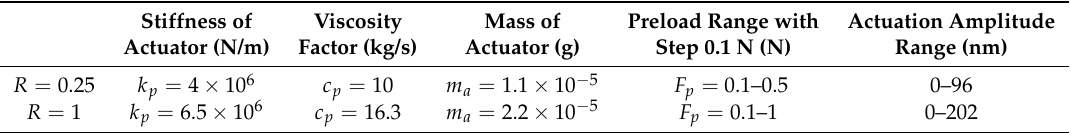
Table 2. Parameter variation dependent on the radius of hemispheres used in